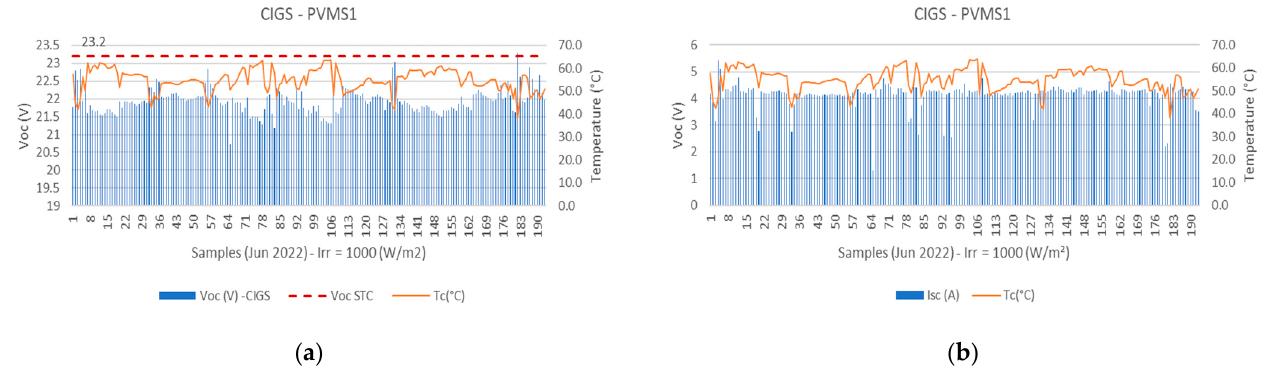
Figure 8. ( a ) Voc/Tc and ( b ) Isc/Tc at Irr = 1000 (W/m 2 ) for CIGS panel during one month.